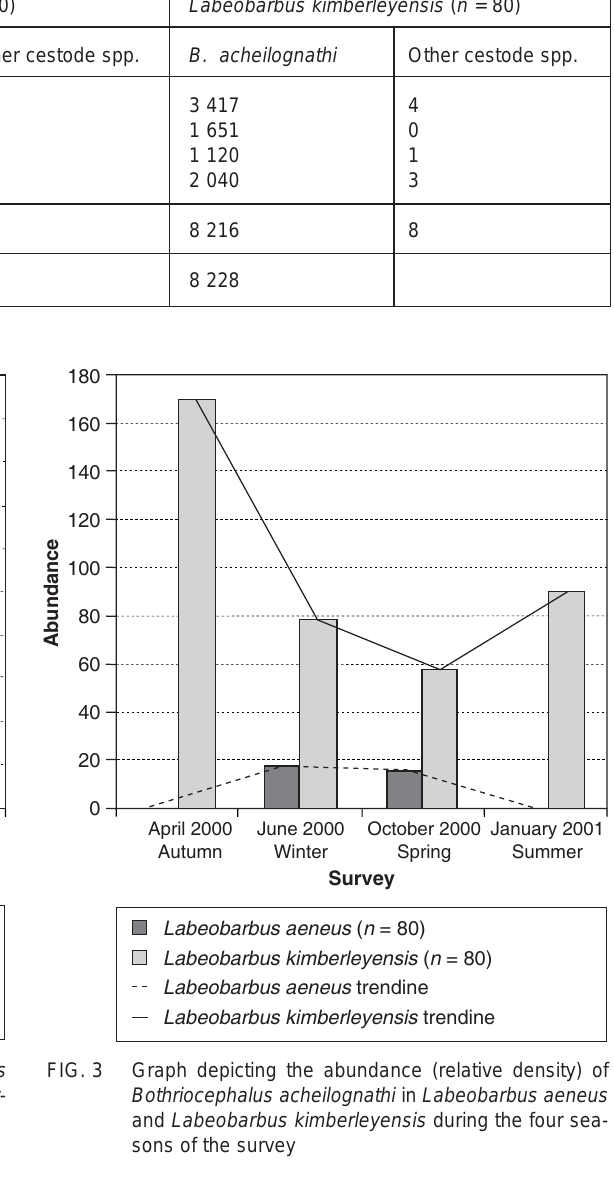
Infection statistics of B. acheilognathi The percentage of hosts (prevalence) infected with B. acheilognathi, and its intensity (mean intensity) and abundance (relative density) in both L. aeneus and L. kimberleyensis are illustrated graphically in Fig. 2, 3 and 4, respectively. A statistical compari- son (T-test) of the two fish species in terms of B. acheilognathi prevalence, abundance and mean intensity is also included to determine whether or not there are significant differences between fish species.